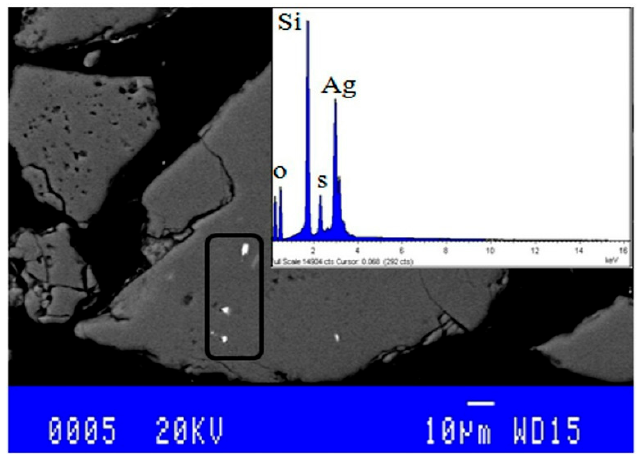
Figure 3. Mixed particles of quartz and silicates. scanning electron microscopy (SEM), secondary electrons.